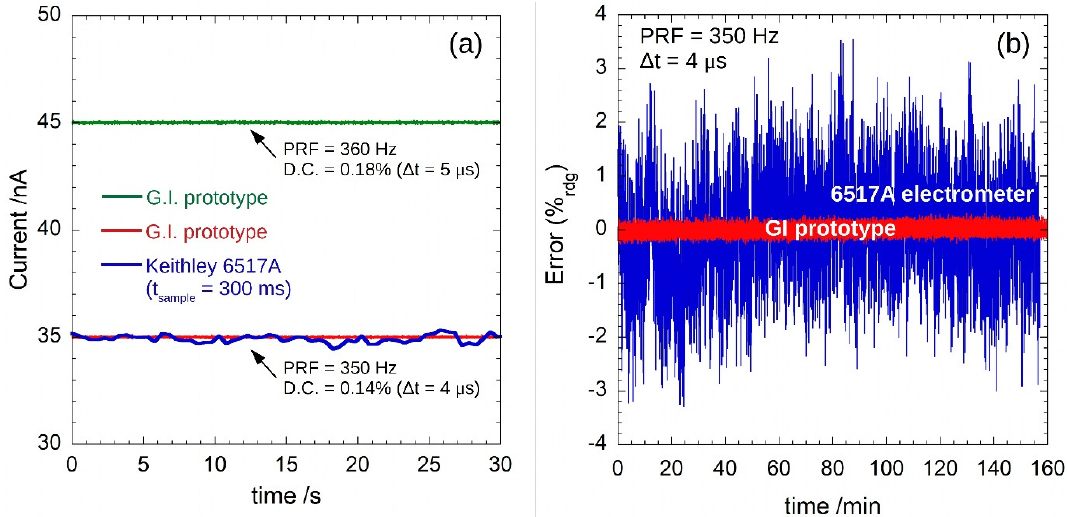
Figure 5. In ( a ), measurement results for an input current with I peak = 25 µA ( PRF and D.C. as reported). Red and green curves are the calculated currents according to Equations (8) and (10) of the acquisition performed by the proposed GI; in blue, the same signal recorded by a Keithley 6517A electrometer. In ( b ), the reading error on 2.7 h for the measurements performed by the GI and the 6517A electrometer for an input current of I peak = 25 µA, PRF = 350 Hz, and D.C. = 0.14% ( Δ t = 4 µs).